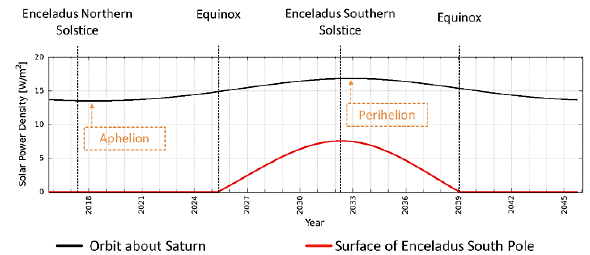
Figure 6: Solar flux for areas perpendicular to the incoming solar radiation (black) and for areas on the surface at the South Pole